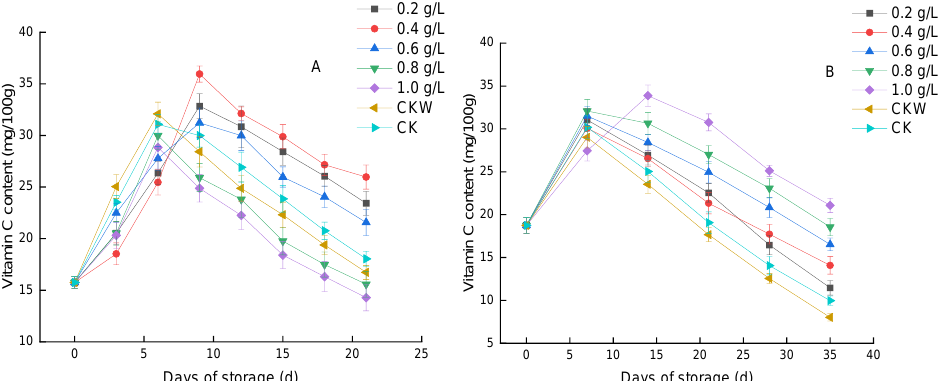
Figure 7. Effects of different Lycium barbarum leaf extract concentrations on the vitamin C content of cherry tomatoes at 20 °C ( A ) and 5 °C ( B ).